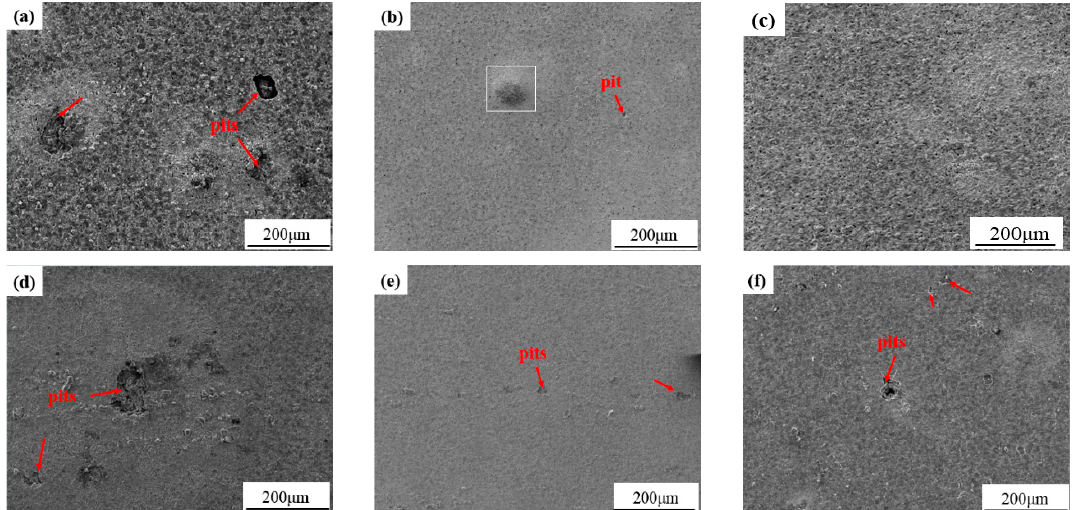
Figure 12. SEM surface morphologies of the coated samples after immersion in 3.5 wt.% NaCl solution for 48 h: ( a ) G0, ( b ) G1, ( c ) G2, ( d ) G3, ( e ) G4, and ( f ) G5.